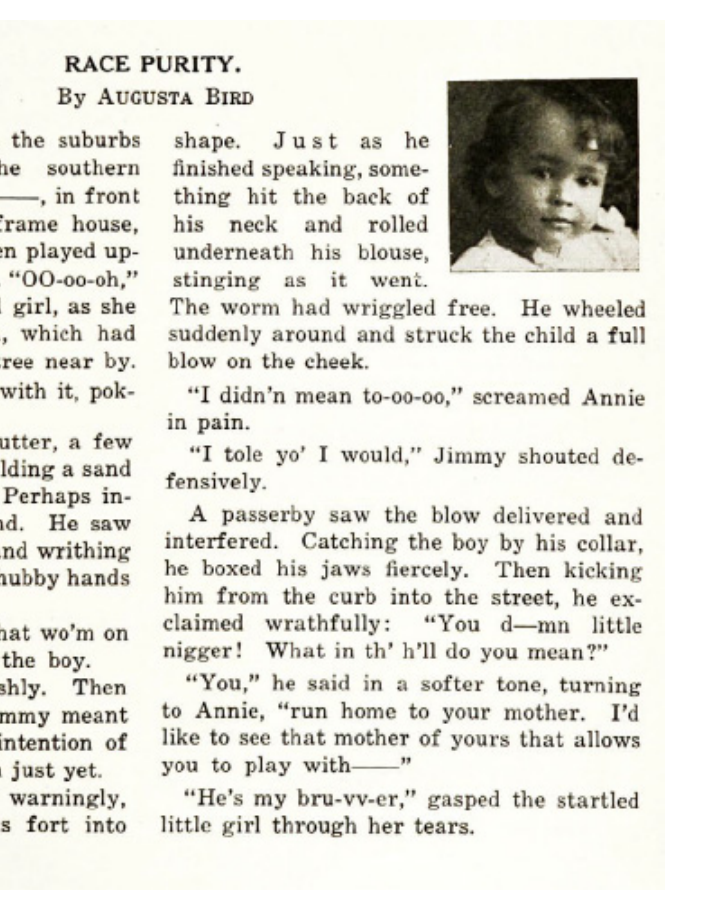
Figure 6. The Crisis 16.6, p. 275, The Modernist Journals Project. https://modjourn.org/issue/bdr511495/, (accessed on 17 January 2022).